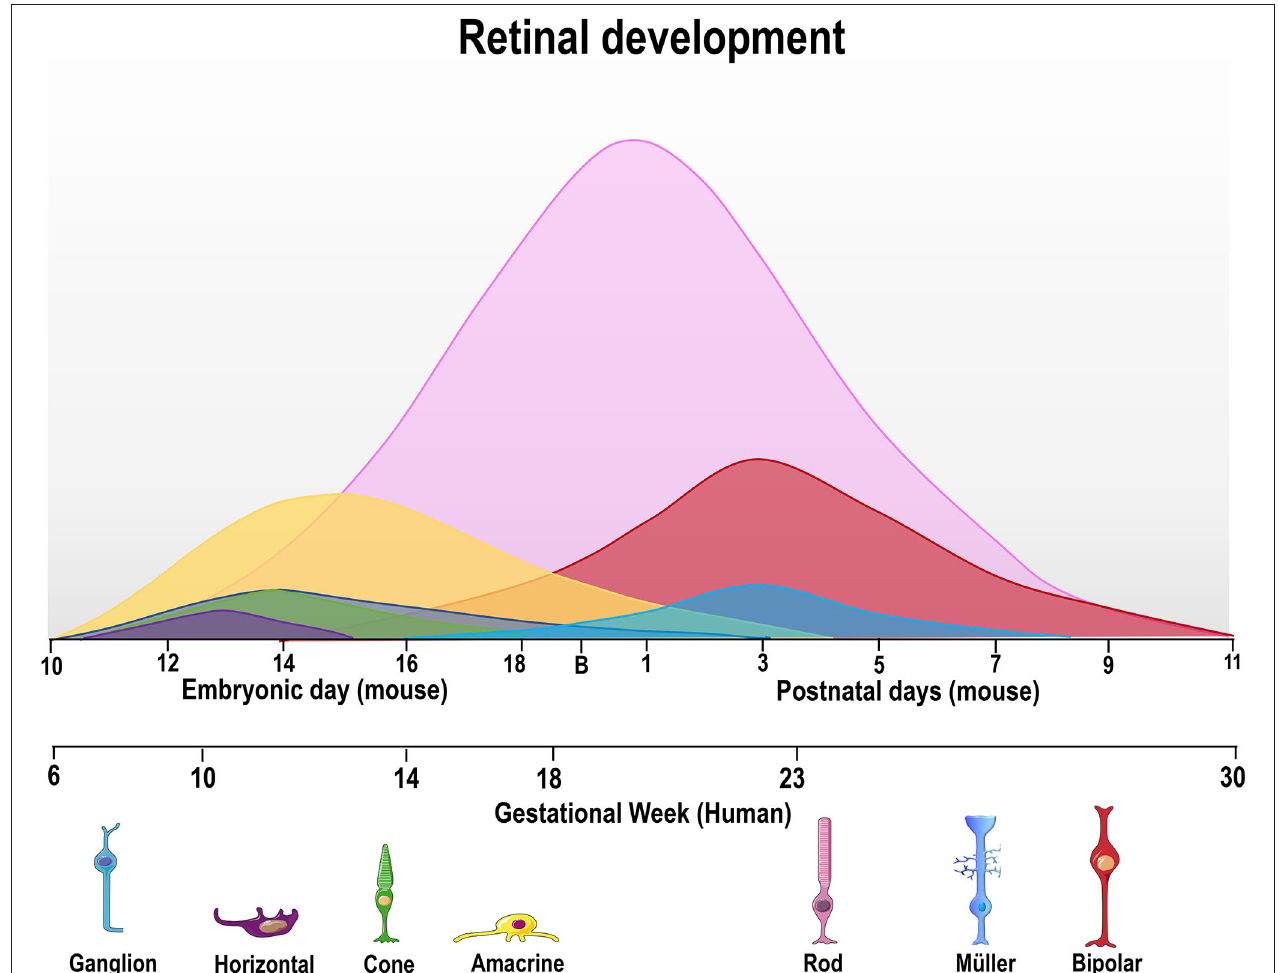
FIGURE 2 | Time course of retinal neurogenesis in human and mice. There are two main waves of retinal cell birth from early and late progenitors. The first wave begins around embryonic day (E) 10–18 in mice and gestational week (GW) 6–18 in humans, with ganglion (dark blue) cells being the first cell type to exit the cell cycle, followed by horizontal (purple), cone photoreceptors (green), and amacrine cells (yellow line). Late progenitors generate rod photoreceptors (magenta line) from E12/GW6, bipolar cells (red line) from E16/GW14 and Müller glial cells (light blue) from E18/GW18 until